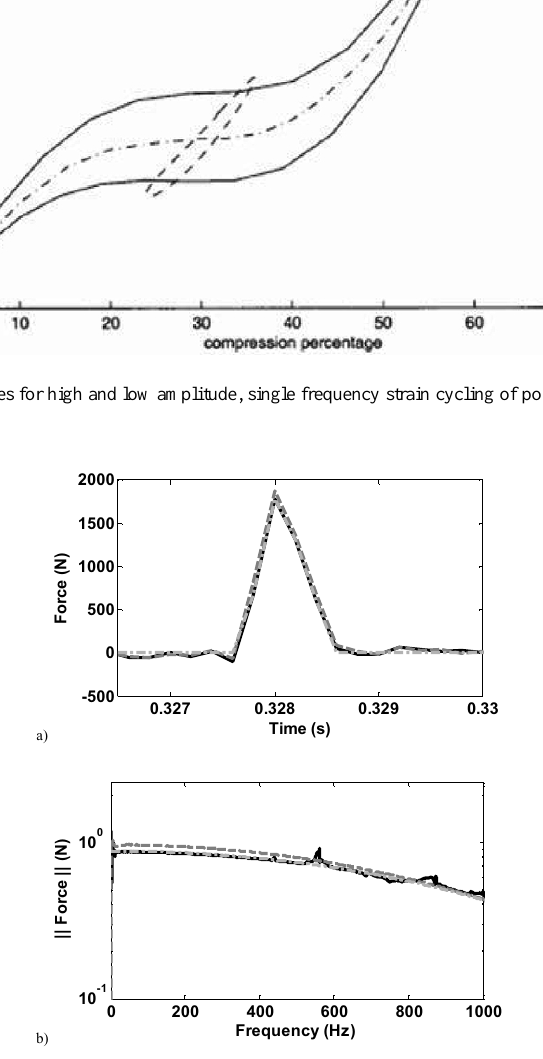
Fig. 24. Original force estimate (——), the applied force (– – –), and the curve-fit estimate (– · – · ) of the force for a high-amplitude impact when the canister is suspended with rubber bands in the a) time and b) frequency domains. estimated peak force is qualitatively much less when using rubber bands as supports, Fig. 24, than when using foam, Fig. 21. The large discrepancies between the preliminary curve-fit force and actual force at low frequencies, as seen in the tests involving foam supports (Fig. 21), are not present when using the less-influential rubber-band